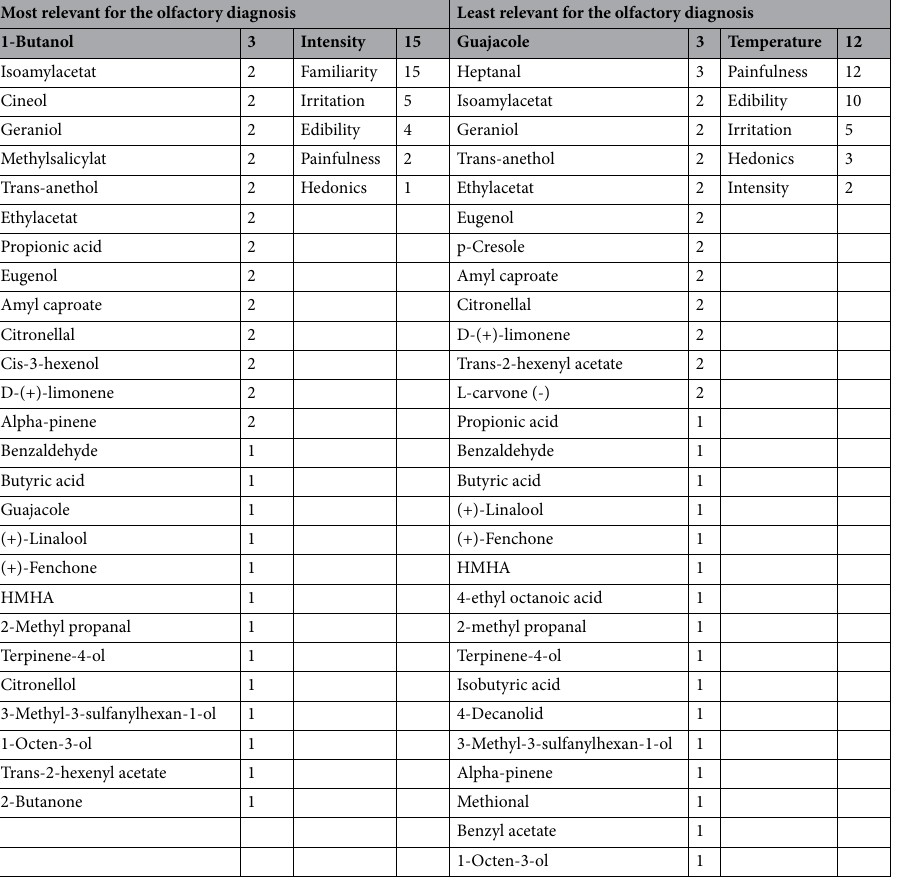
Table 2. Odors identified to represent characteristics that best distinguish between olfactory diagnoses or, on the other hand, are least distinctive between olfactory diagnoses. The table shows the items assigned to ABC set “A” by computed ABC analyses of the rank products of odor property importance for the olfactory diagnosis. The left part of the table shows the most relevant odors and properties in descending order of occurrence in ABC set “A”. The right part of the table shows the opposite analysis, i.e., aiming at the odors and properties that were least distinctive between the olfactory diagnoses of normosmia versus hyposmia. The original data consisted of an odor and a rated perceptive property. The numbers in the table show how many times an odor or a perceptive property was assigned to ABC set “A”, i.e., to the set of most relevant